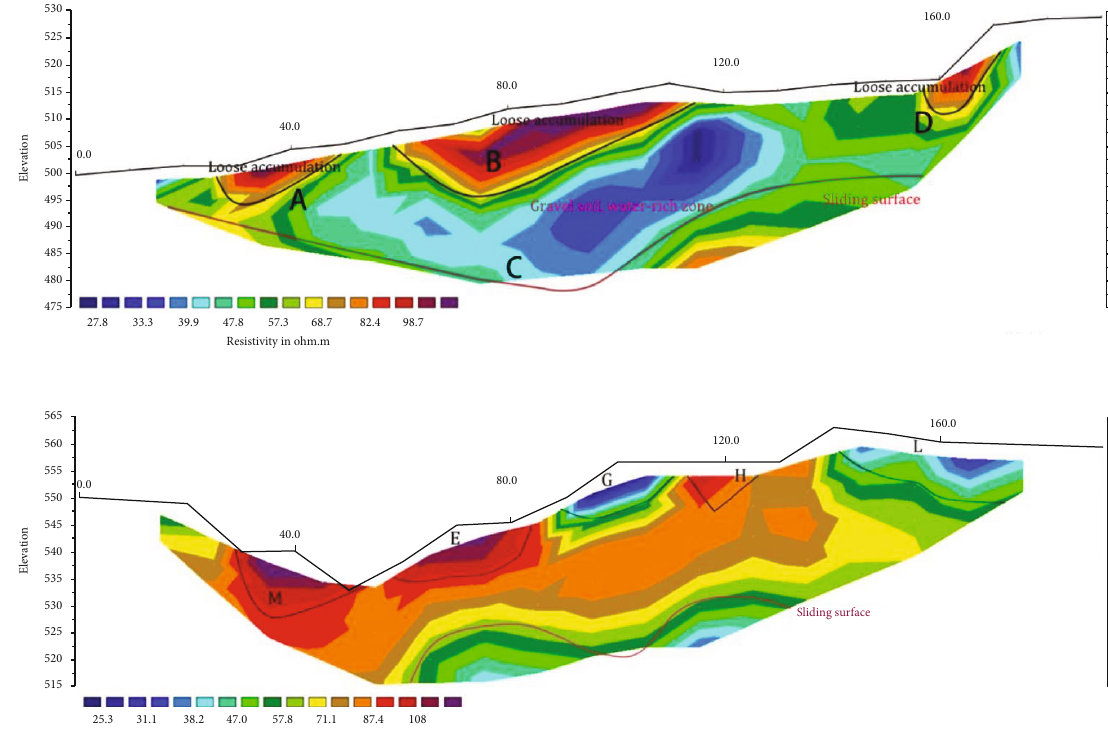
Figure 14: Measurement results in